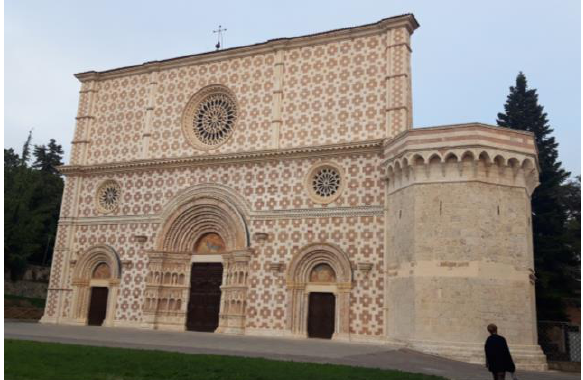
Figure 4. The Collemaggio Basilica in L’Aquila, that was restored after the 2009